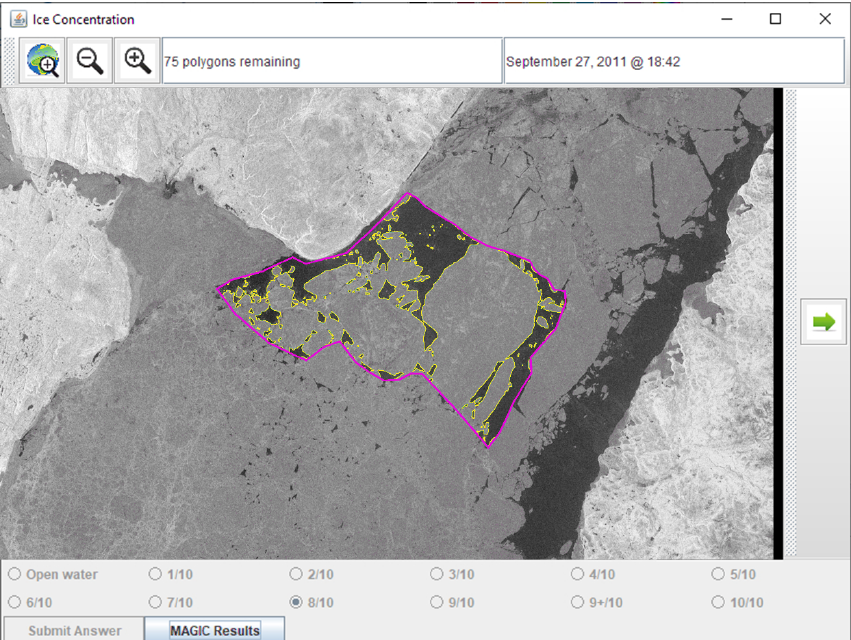
Figure 5. After each analyst input an ice concentration value (Fig. 4), they were presented with an outline of the segmentation results from MAGIC. Analysts were able to toggle the segmentation results on or off. Answers were locked after input so that they could not be changed after the segmentation results became visible. RADARSAT-2 Data and Products © MDA Geospatial Services Inc. (2012) – All Rights Reserved. RADARSAT is an official trademark of the Canadian Space